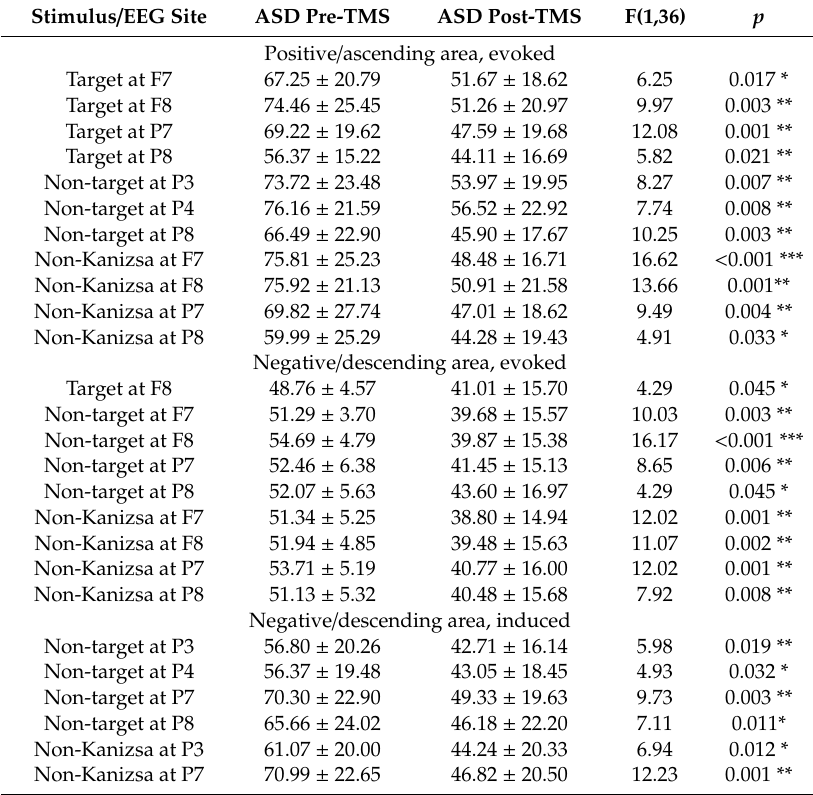
Figure 4. Negative slope area of evoked gamma oscillations in response to target Kanizsa (TRG), non-target Kanizsa (NTG), and non-Kanizsa (NOK) stimuli in typical children, children with ASD pre- and post-TMS treatment. Stimulus (TRG, NTG, NOK) × Group (CNT, ASD pre-, ASD post-TMS) interaction was significant at the parietal sites (P7, P8). Note higher area of responses at baseline and a decrease of areas in response to non-target items post-TMS similar to effects at the frontal sites. Table 2. E ff ect of rTMS course on evoked and induced gamma oscillations’ positive and negative areas in response to rare target Kanizsa (Target), rare non-target Kanizsa (Non-target) and frequent non-Kanizsa standard (Non-Kanizsa) stimuli at the frontal and parietal EEG sites in 19 participants with ASD (Means ± SD). * p < 0.05; ** p < 0.001; *** p < 0.001